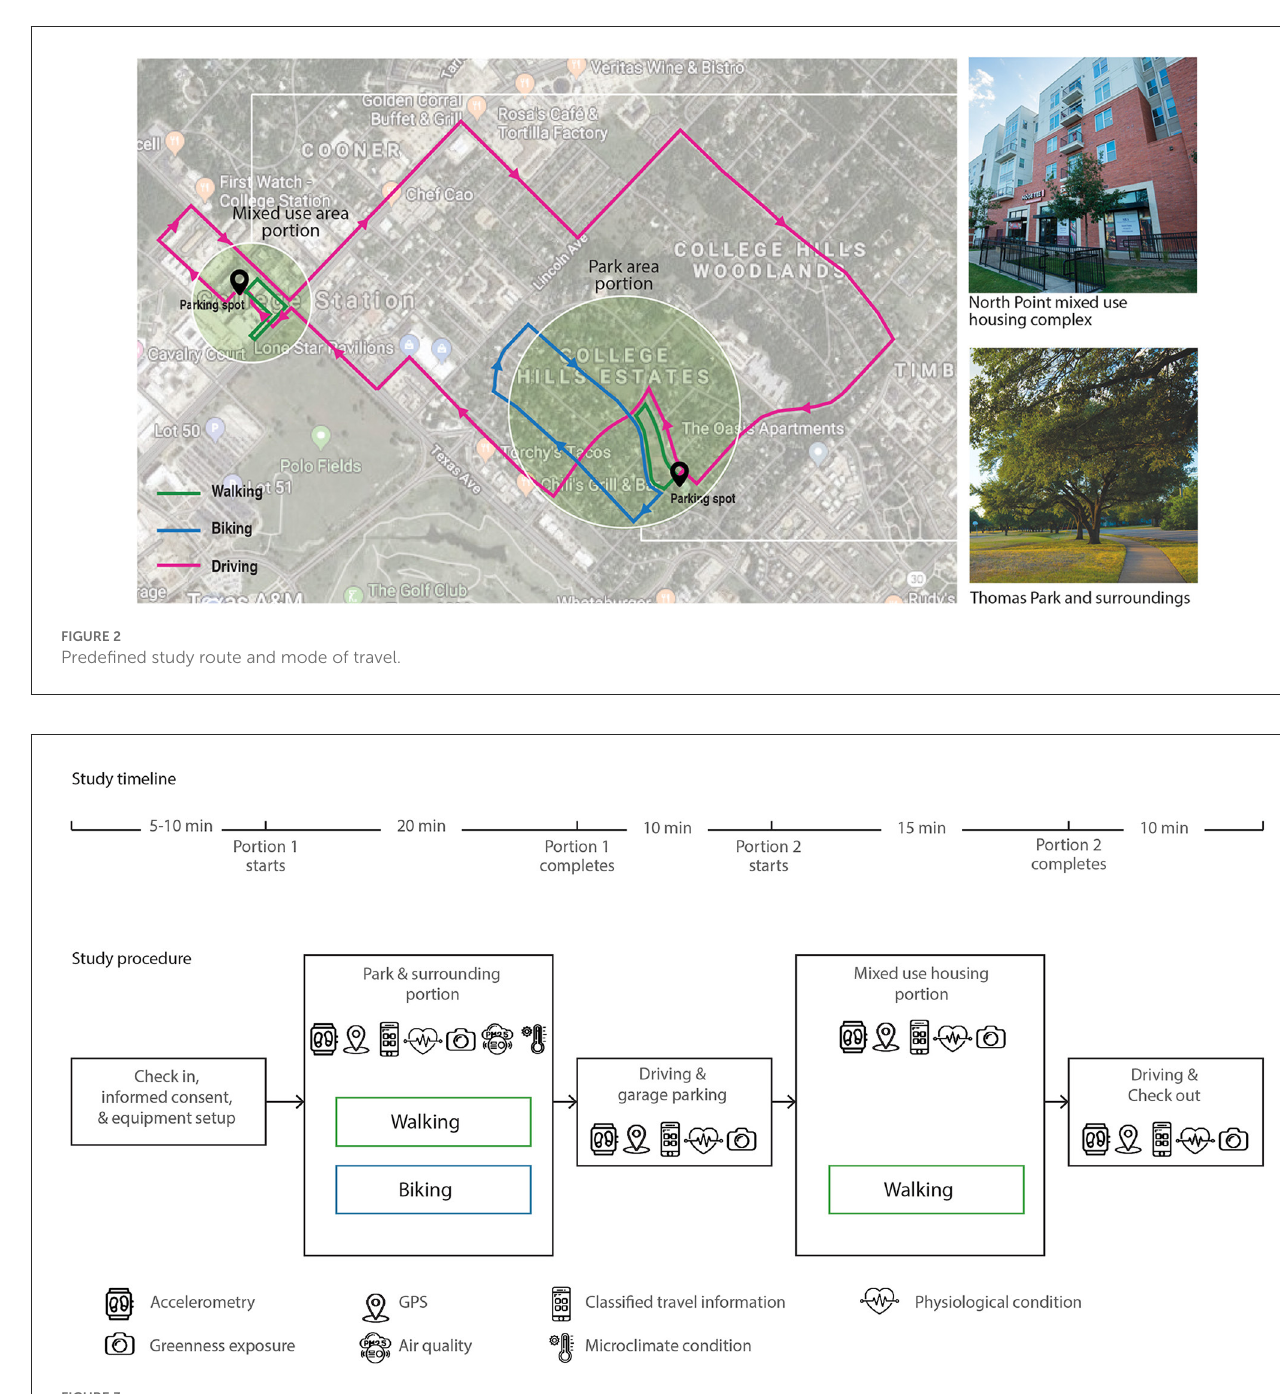
FIGURE3 The procedure and instruments of the field